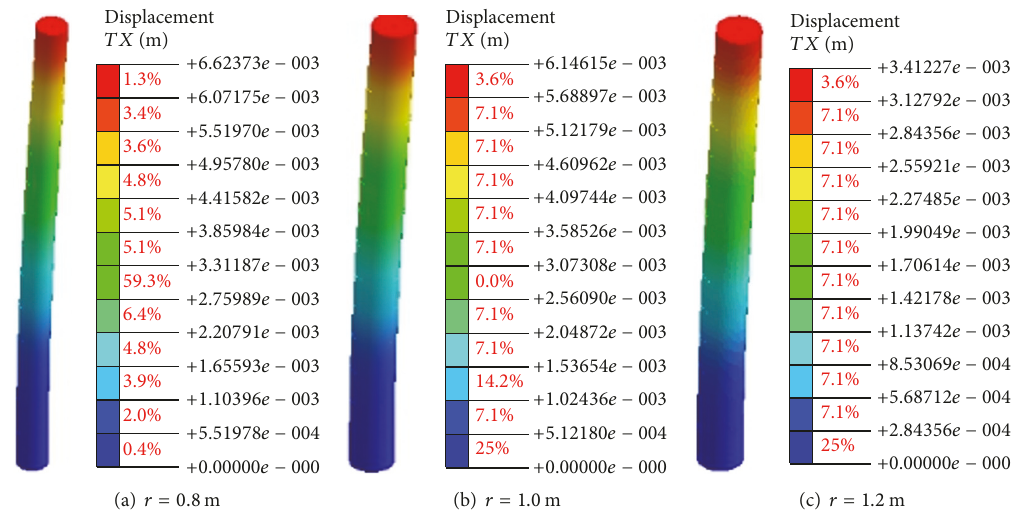
Figure 8: The lateral displacement distribution cloud chart of pile body under different pile diameters.